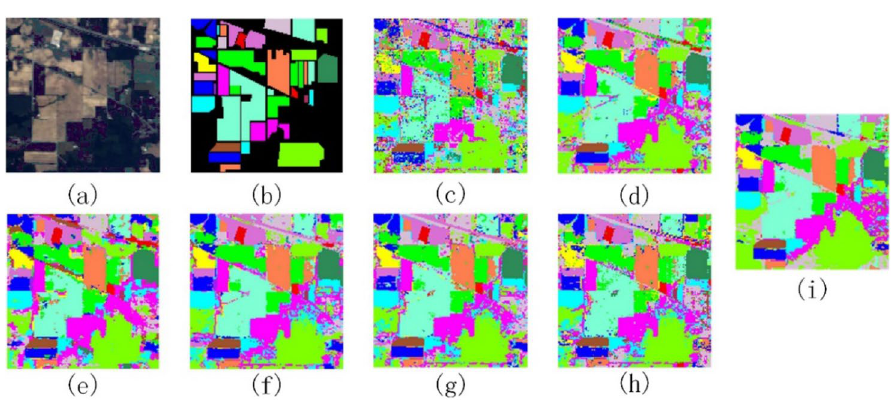
Figure 8. Indian Pines data classification results. ( a ) False-color map; ( b ) Ground-truth map; ( c ) PCA; ( d ) EMP; ( e ) SAE; ( f ) 3D-CNN; ( g ) Gabor-Based; ( h ) RPNet; ( i )